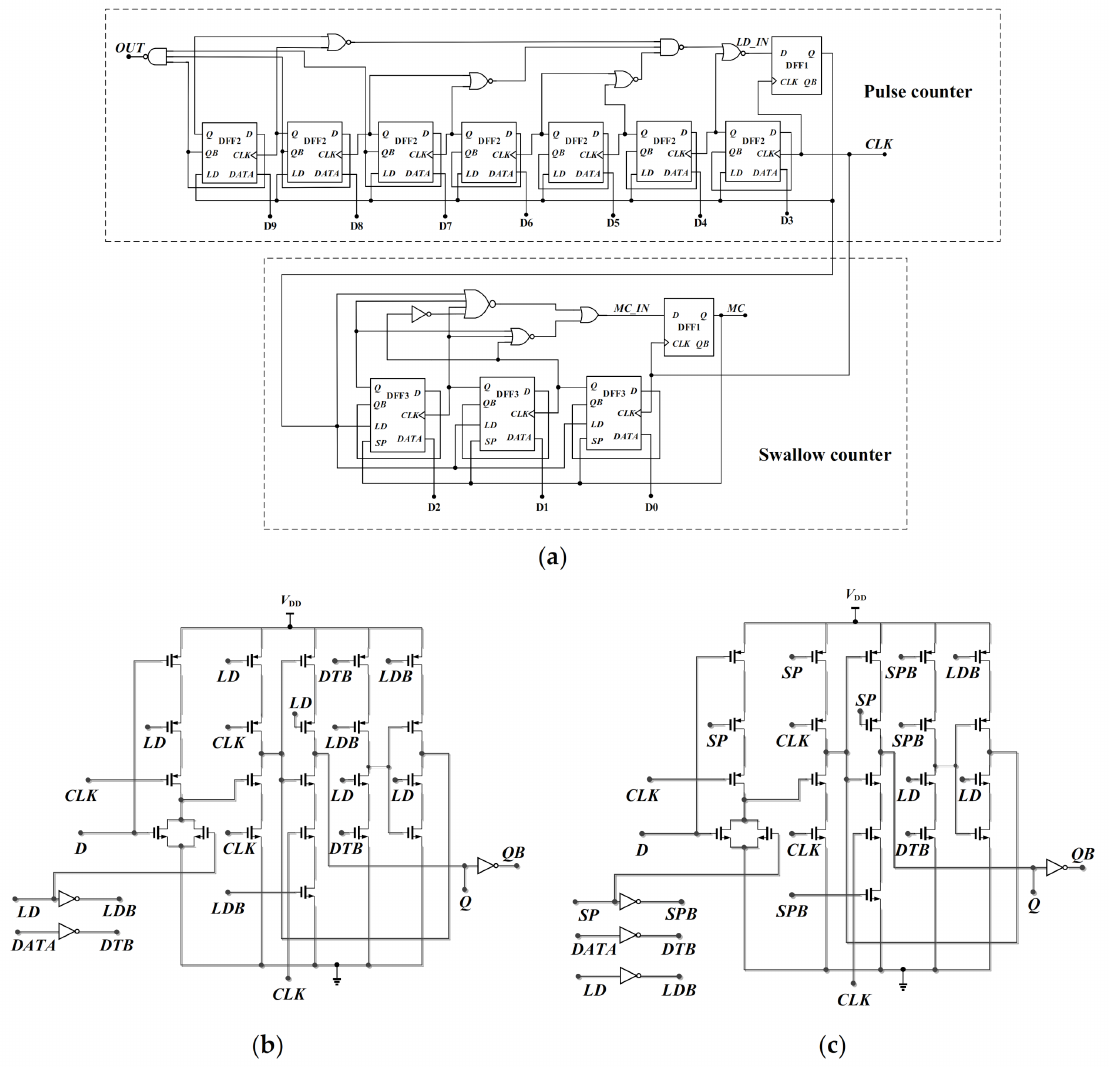
Figure 8. Diagrams: ( a ) block diagram of the PS counters; ( b ) schematic diagram of DFF2 in counter-P; and ( c ) schematic diagram of DFF3 in